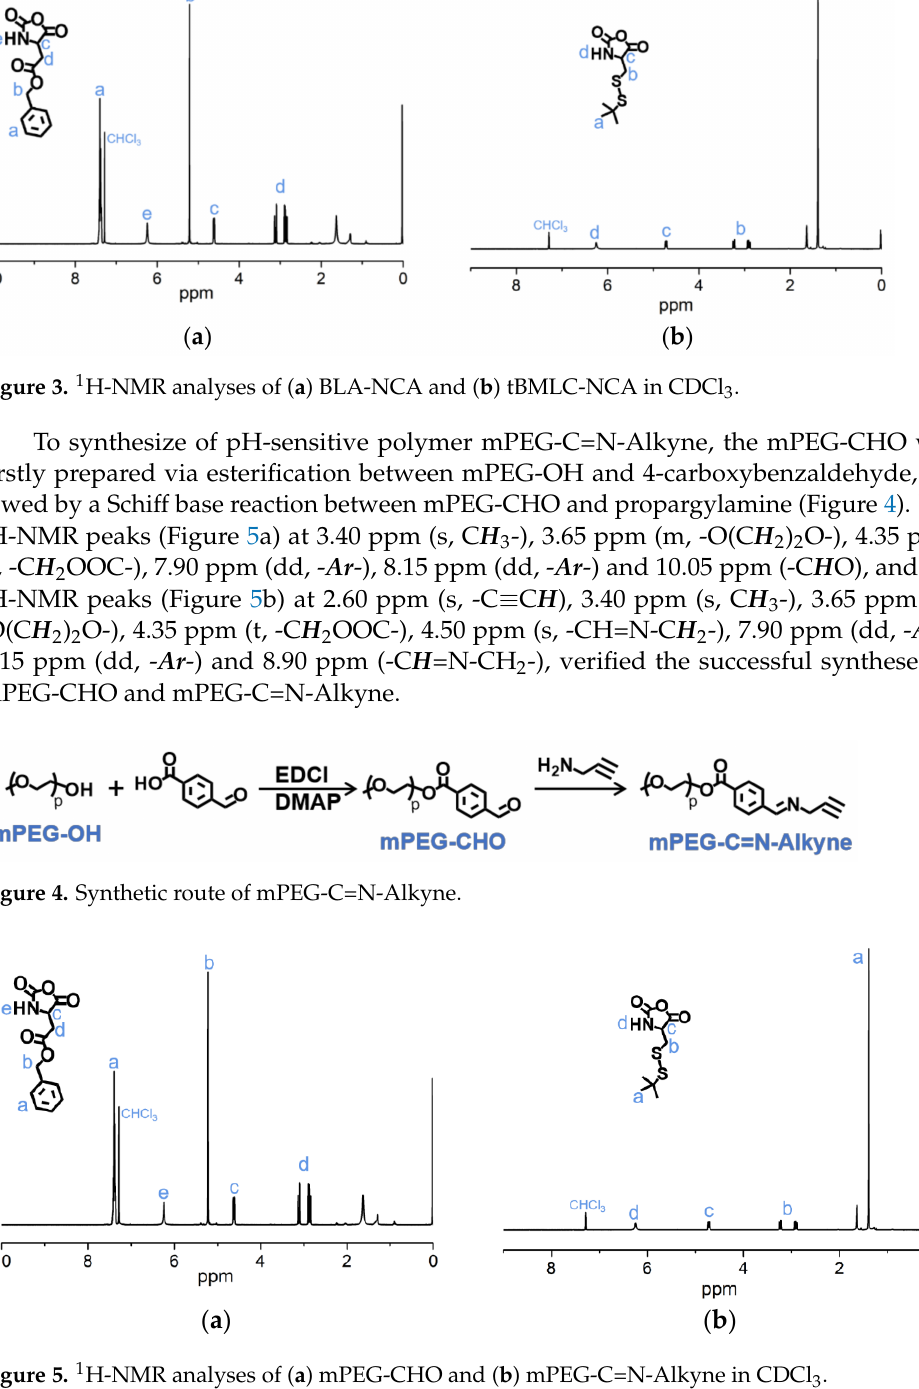
( b ) Figure 5. 1 H-NMR analyses of ( a ) mPEG-CHO and ( b ) mPEG-C=N-Alkyne in CDCl 3 .